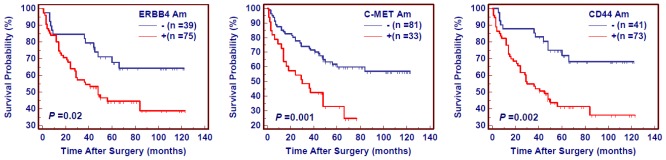
The effect of amplification of ERBB4, C-MET and CD44 on poor survival of gastric cancer patients without residual tumor after surgery. Kaplan–Meier analysis of survival was performed according to the status of gene amplification in a cohort of gastric cancers. The patients with gene amplification had poorer survival than the patients without gene amplification. Am, amplification; +, harboring gene amplification; −, the lack of gene amplification.